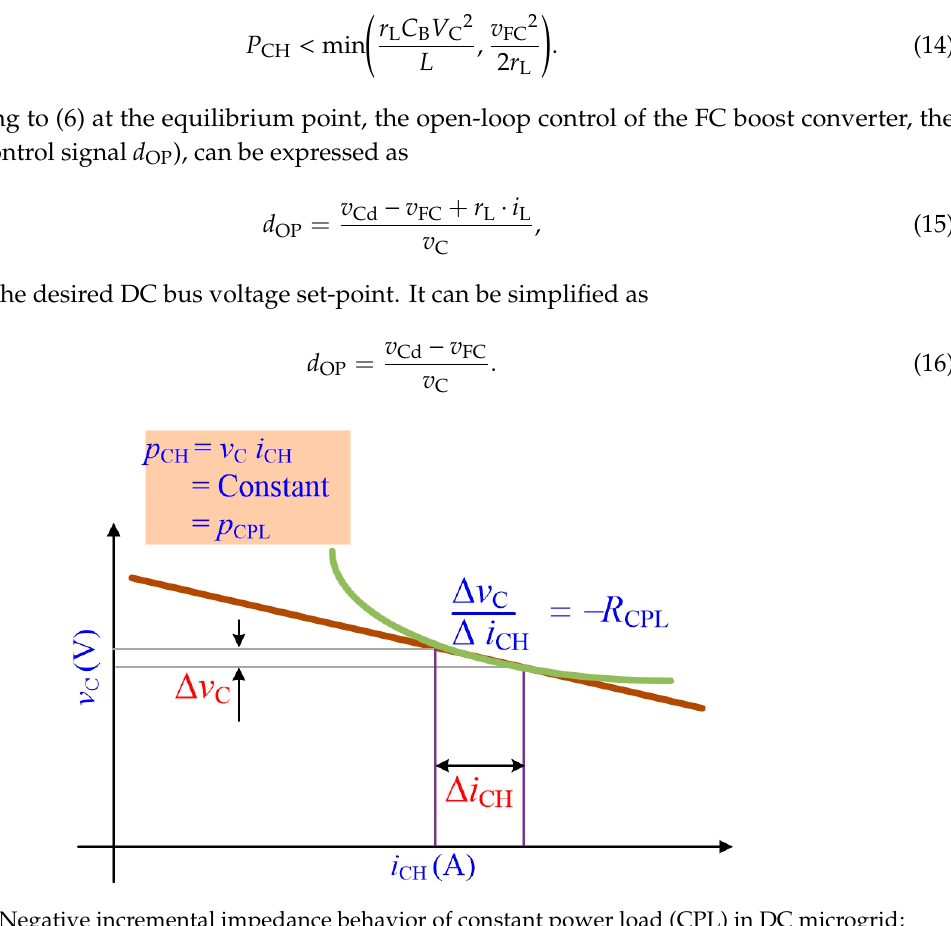
Figure 3. Negative incremental impedance behavior of constant power load (CPL) in DC microgrid; the DC output voltage decreases with an increase in load current.